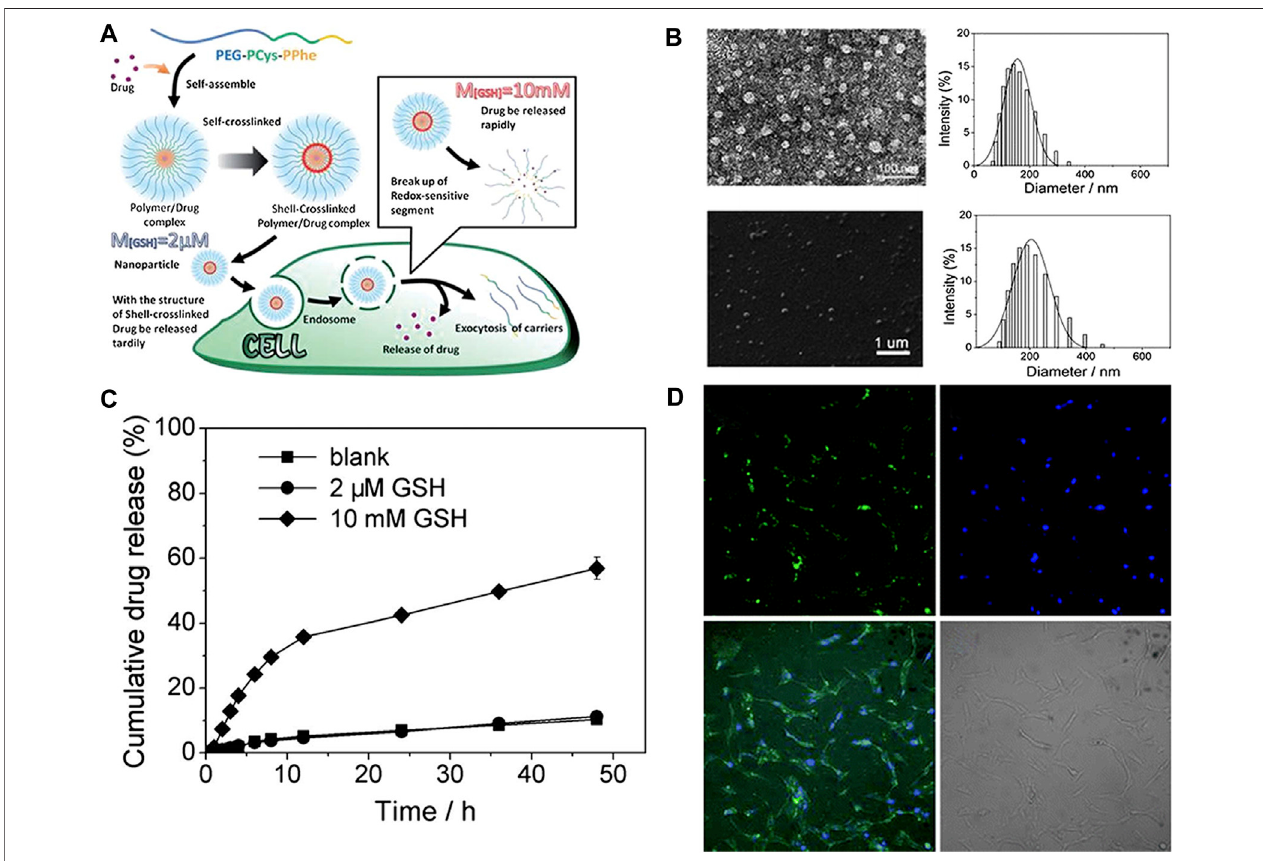
FIGURE 7 | Characterization of self-assembly process and drug release of the nanogels (Wang et al., 2012). (A) Self-assembly process and drug release of the nanogels. (B) TEM image and particle size distribution of nanogels and the scanning electron microscope image and particle size of nanogels in the tetrahydrofuran solution. (C) Drug release of PEG-PCys-PPhe. (D) Confocal laser scanning microscopy (CLSM) image regarding co-incubation of HeLa cells and PEG-PCys-PPhe.